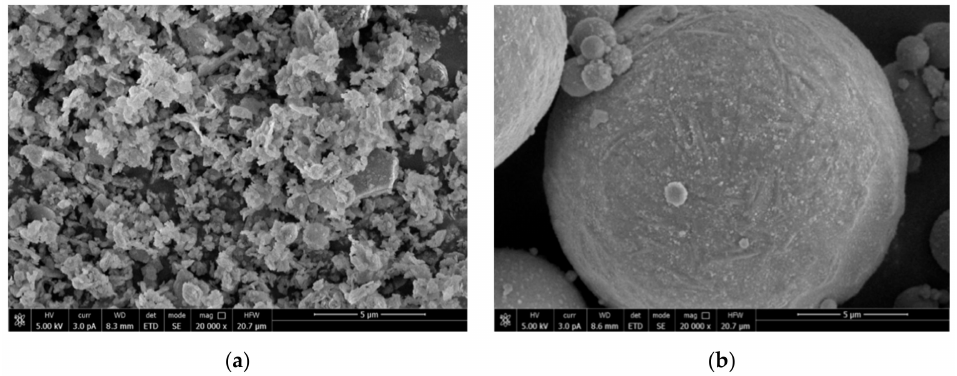
Figure 3. Micro morphology of mineral admixtures. ( a ) Metakaolin, ( b ) Superfine fly ash. UFA is made by Henan Zhengzhou Huifeng New Material Co., Ltd. (Zhengzhou, China), particle size: 5.95 µ m. As shown in Figures 2b and 3b, it is a yellowish-brown pow- der with round shape, and greater average particle size than MK from a micro perspective.